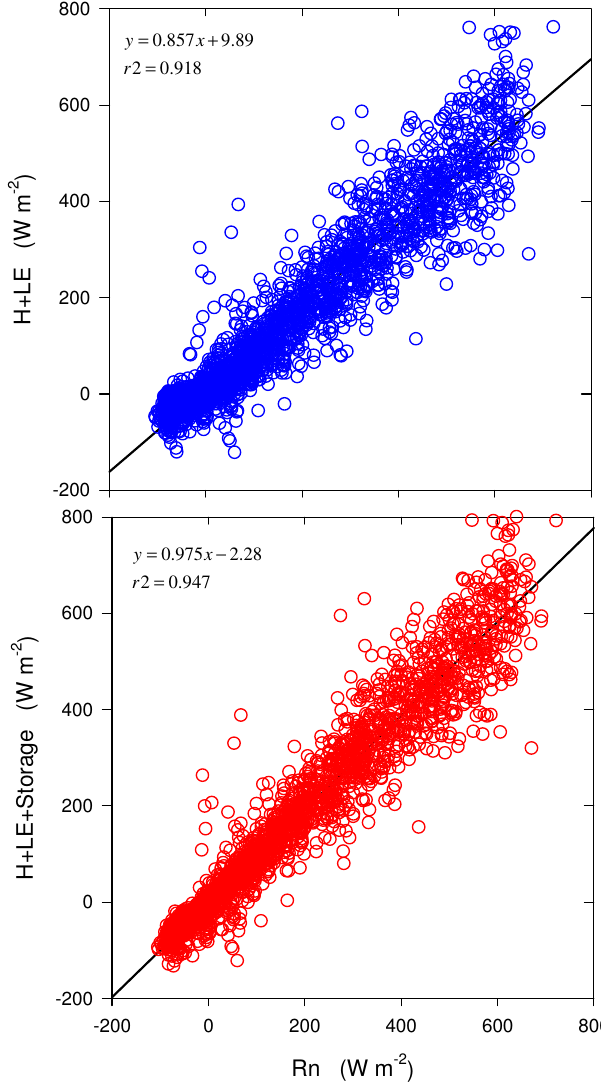
Fig. 8. The sum of the turbulent fluxes versus net radiation without (top) storage flux and with (bottom) the total storage flux